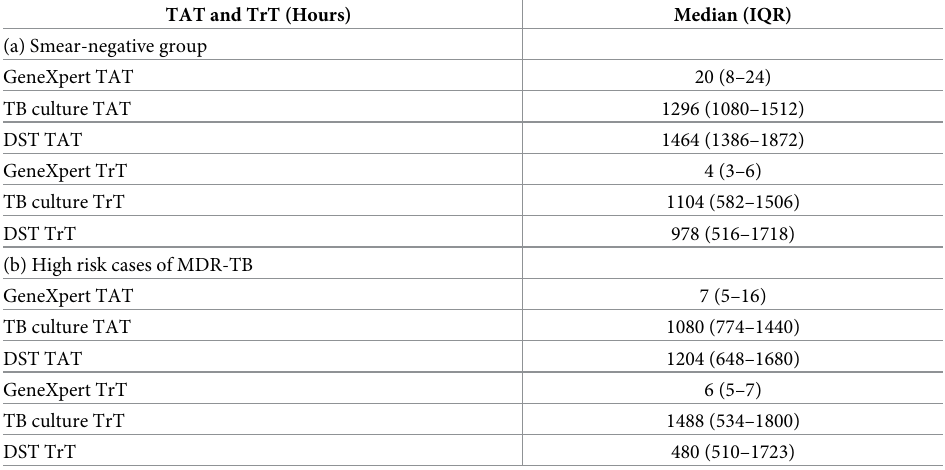
Table 4. Turnaround time (TAT) and Treatment time (TrT) for laboratory test results and treatment